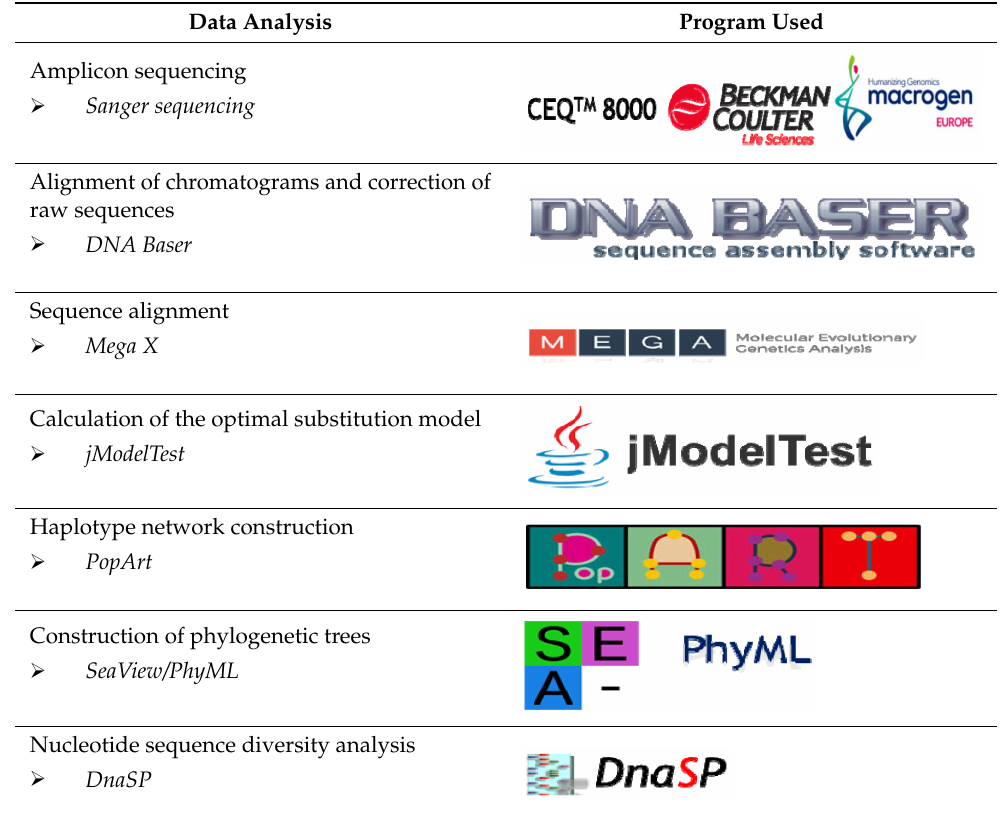
Table 4. List of programs used for data analysis.